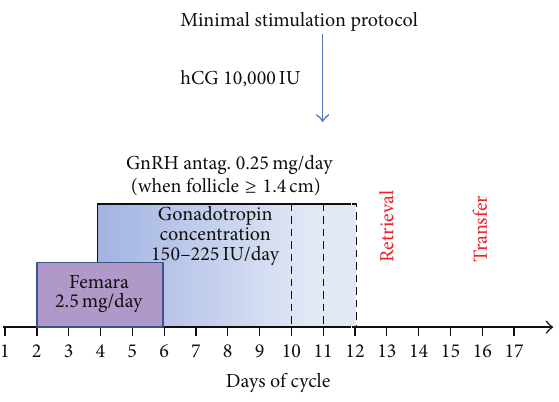
Figure 1: Treatment scheme for the minimal stimulation protocol.